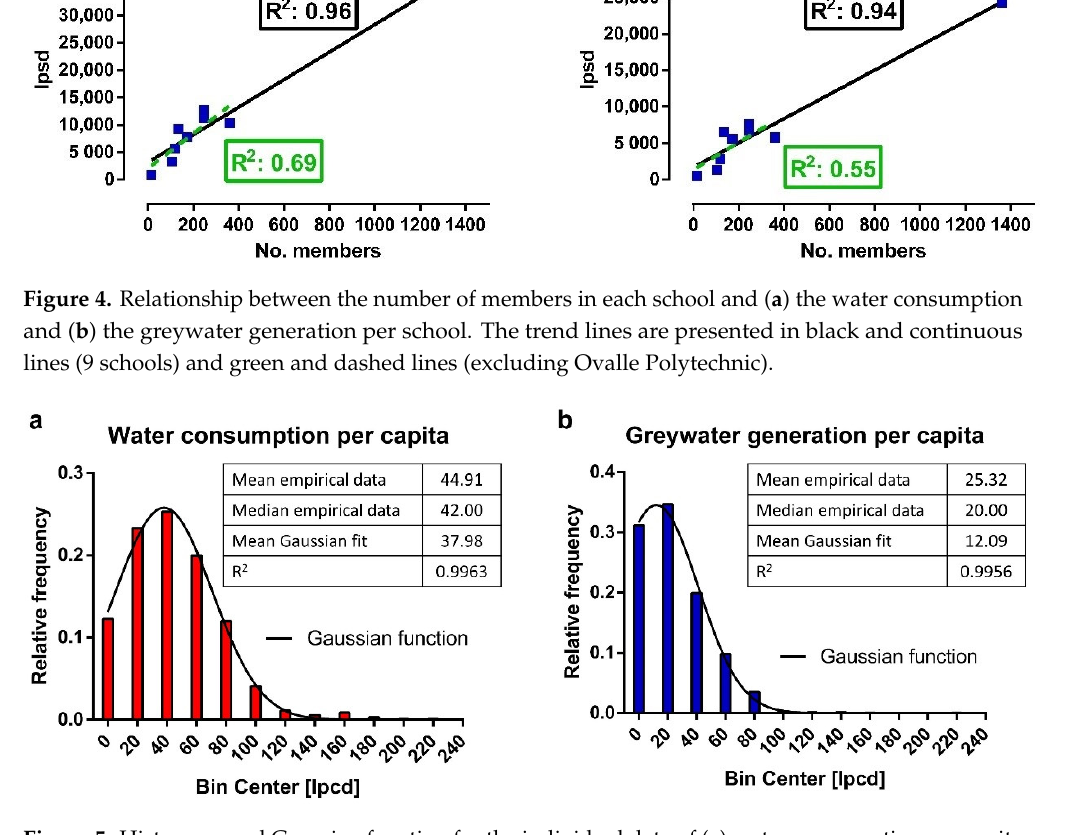
Table 3. Profile of the household respondents.